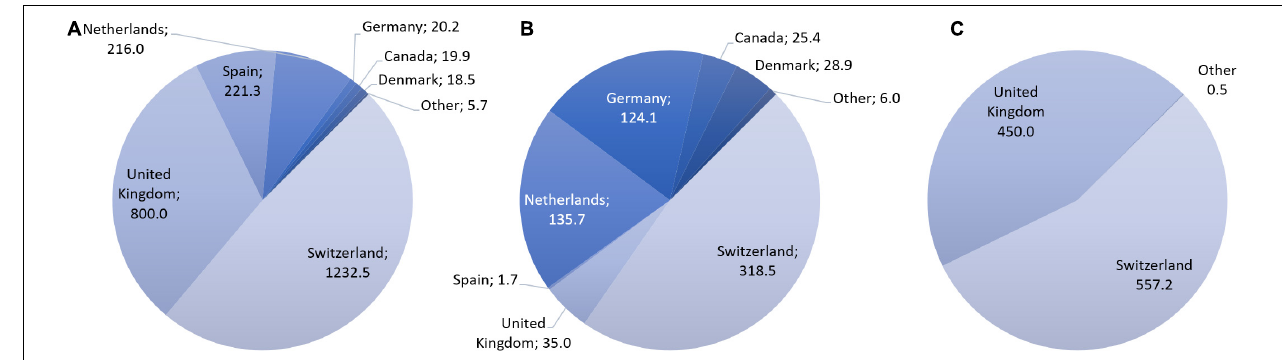
FIGURE 2 | Stocks (A) , consumption (B) , and manufacture (C) of diamorphine in kg per country, 2019. Based on data requested from